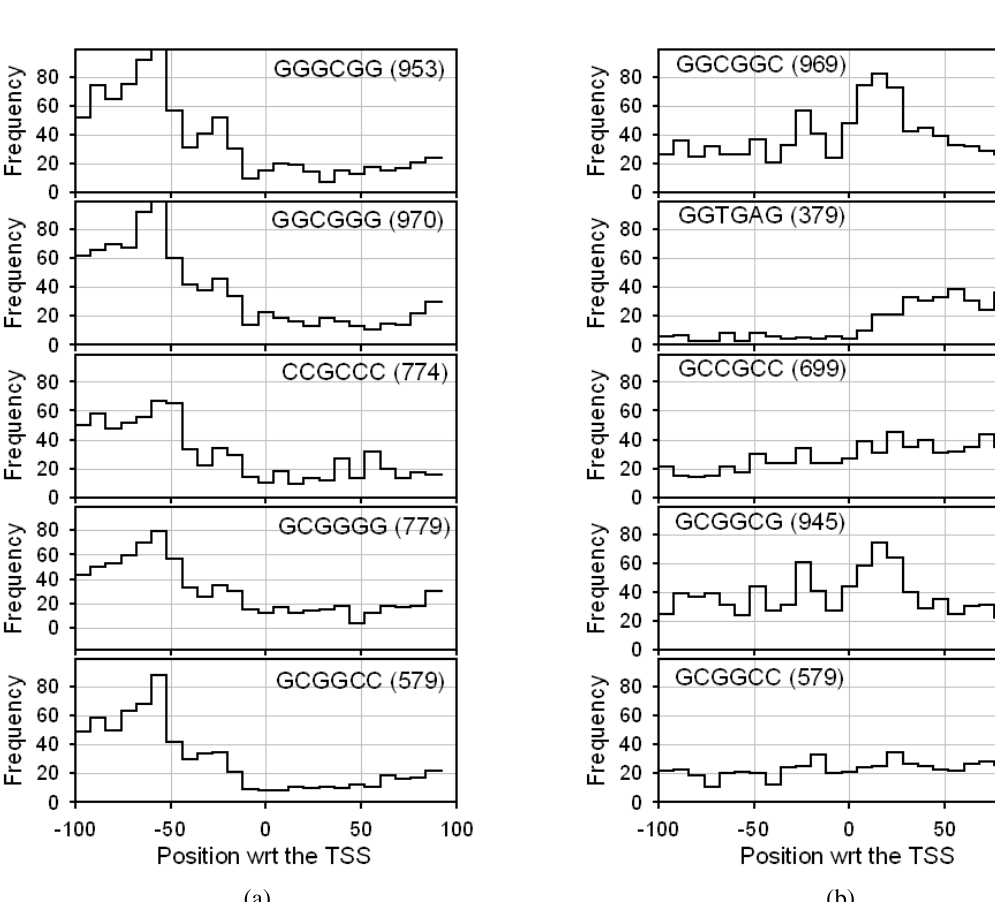
Figure 3: (a) The distribution of the most five common hexanucleotides on the promoter side of the TSS are seen above. It is clear that the most of them show a peak at / around –50 upstream from the TSS. The actual sequences and their total counts are seen in the respective graphs. This distribution has been plotted as a histogram with a bin size of 8. All the graphs have been plotted with an identical scale for ease in visual comparison. (b) The positional distribution of the five most common hexanucleotides on the coding side of the TSS. We note that some of them show peaks on both sides of the TSS. The actual sequences are indicated along with the frequency in parenthesis. We see clear peaks very close the TSS, which is expected (see text for